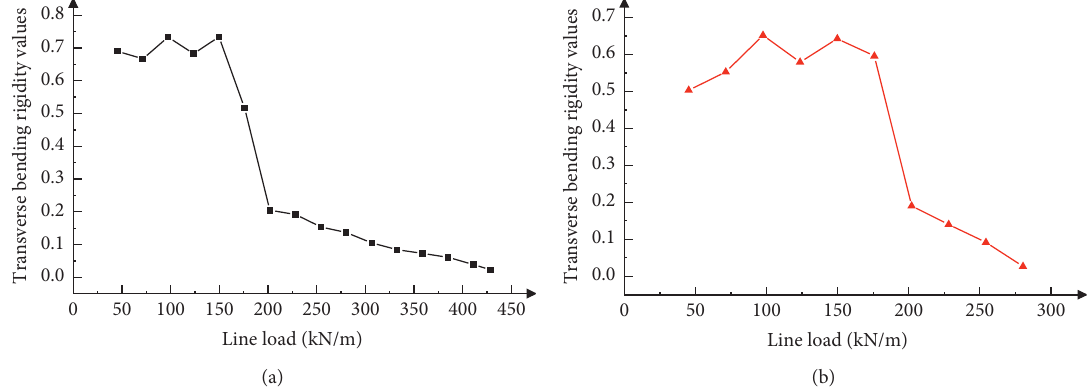
Figure 16: Relationship of the value of η and the line load. (a) Stagger-jointed rings. (b) Straight-jointed rings.